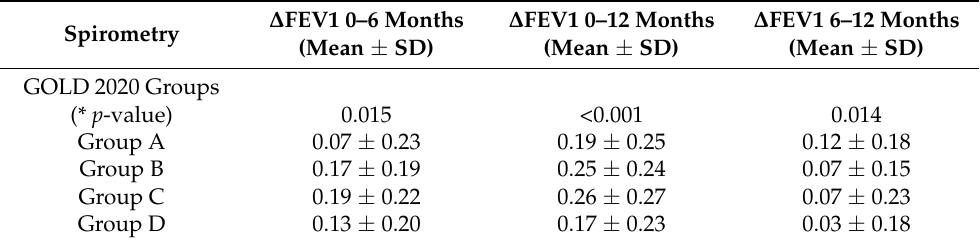
Table 4. Change of FEV 1 (L) between 0–6, 0–12 and 6–12 months based on GOLD COPD 2020 groups.